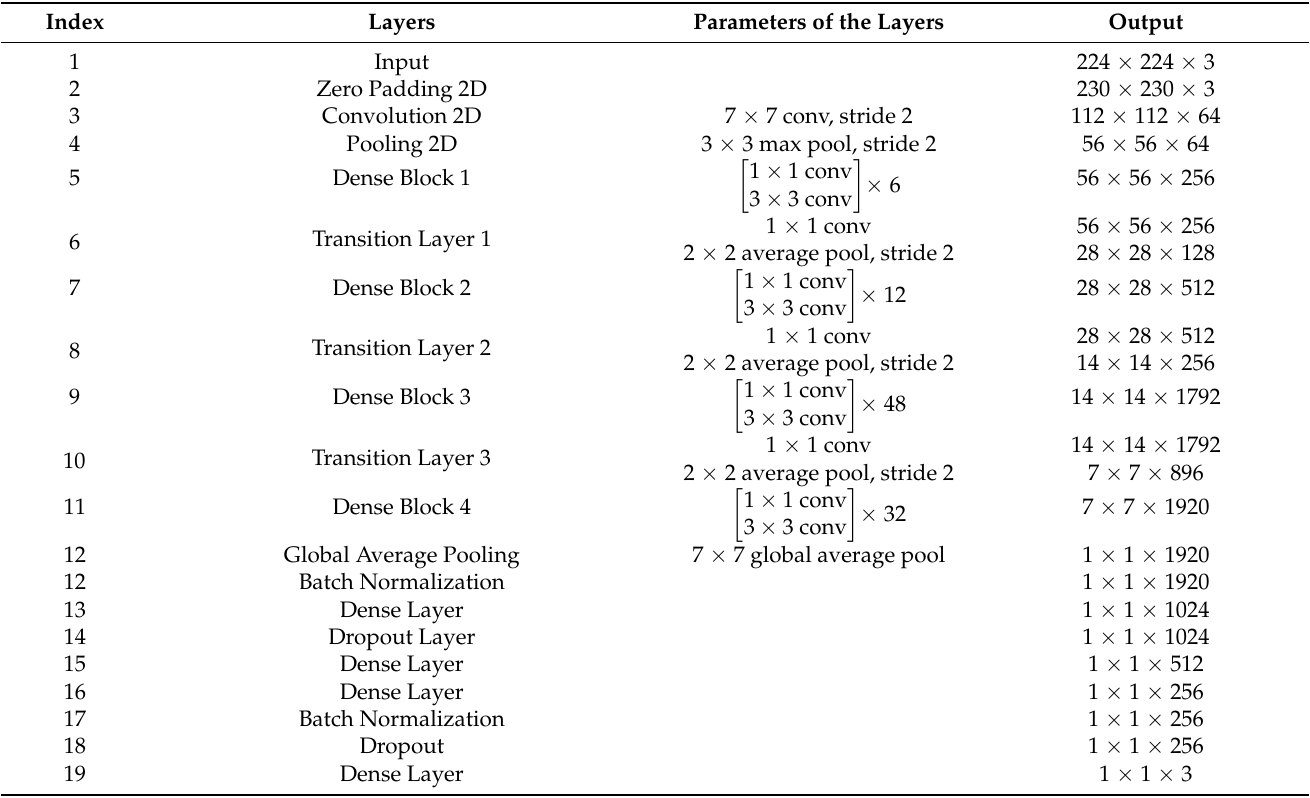
Table 4. The dimensions of different layers of